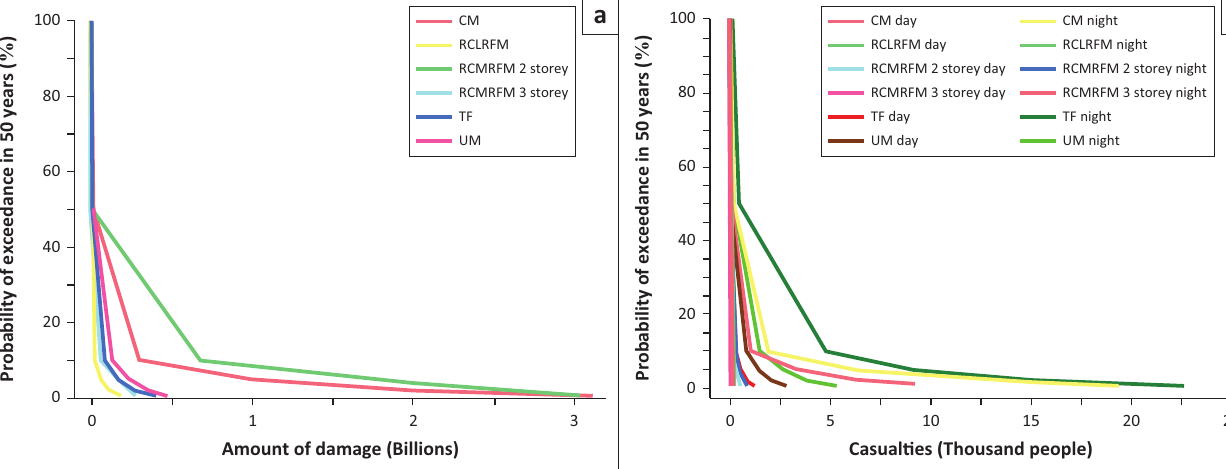
Figure 7. The concaved-shaped curve observed in all curves describes that the smaller the probability exceedance, the greater the damage.